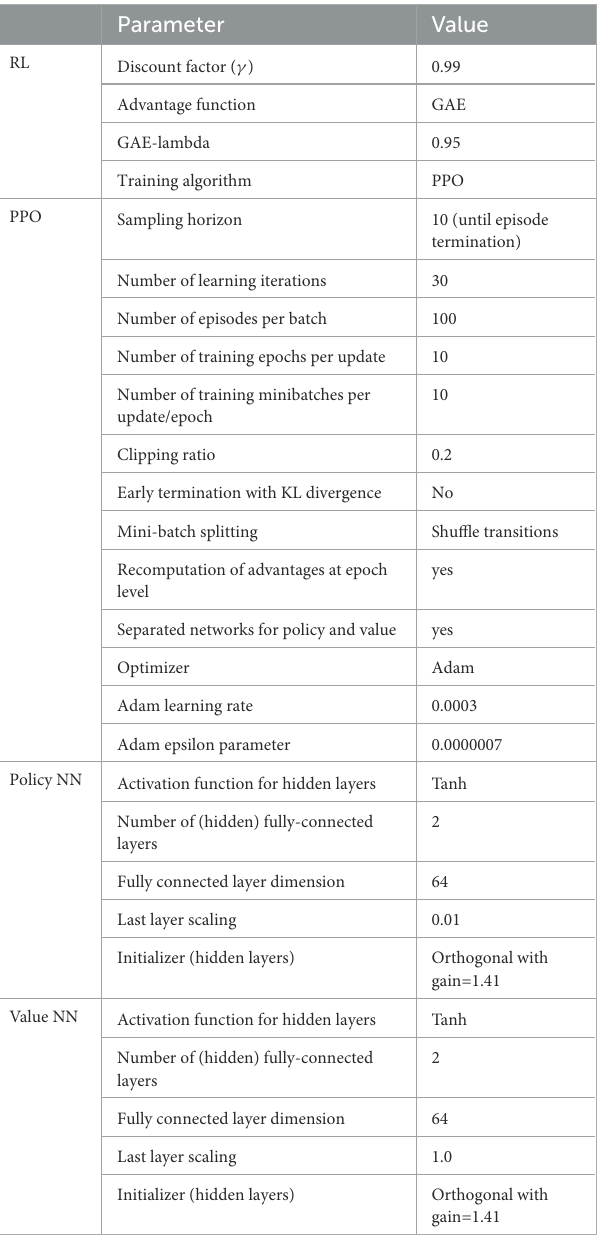
TABLE 10 Training hyperparameters.